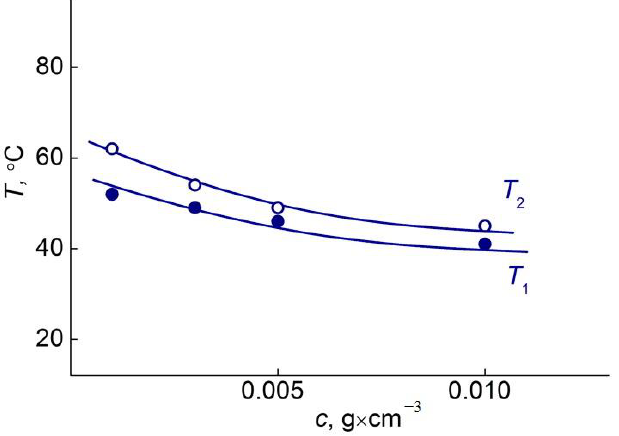
( b ) Figure 11. ( a ) Light transmittance vs. temperature at different concentrations of pPEM, %wt.: 0.1 (1), 0.25 (2), 0.5 (3), 2.0 (4); ( b ) Effect of polymer concentration on the Tpt: pEPM (1), pPEM (2).